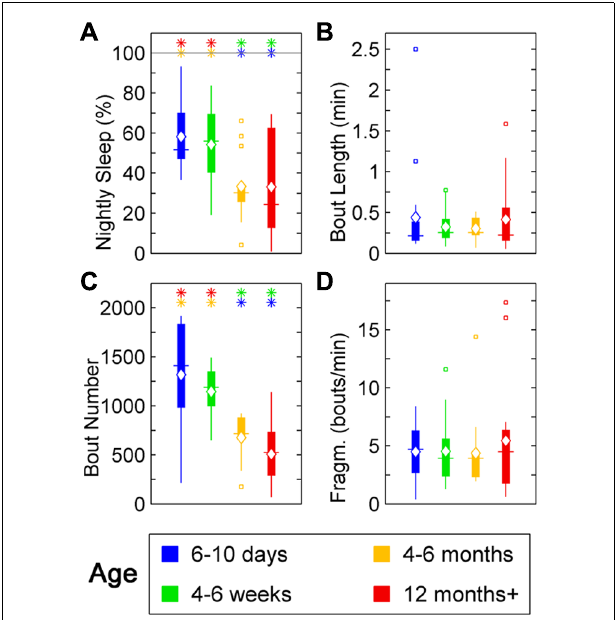
FIGURE 5 |Wake parameters for zebrafish during the night for age groups: 4–6 days post-fertilization (group 1, blue), 4–6 weeks (group 2, green), 4–6 months (group 3, orange), and 12 months + (group 4, red). Colored asterisks above bars indicate a statistically significant difference between the bar group and the group with the corresponding color of the asterisk. (A) Percentage wake time. Larvae (groups 1 and 2) spend less time awake during the night than adult fish (groups 3 and 4). (B) Mean wake bout duration.The wake bout lengths in larvae (groups 1 and 2) are significantly shorter than in adult fish (groups 3 and 4). (C) Number of sleep bouts for groups 1–4. Larvae (groups 1 and 2) show significantly more sleep–wake transitions than adult fish (groups 3 and 4). (D) Sleep bout fragmentation (bouts/min).The wake time of larvae (groups 1 and 2) is significantly more fragmented than for adult zebrafish (groups 3 and 4). Diamond, white line, and squares indicate mean, median, and outlier values,